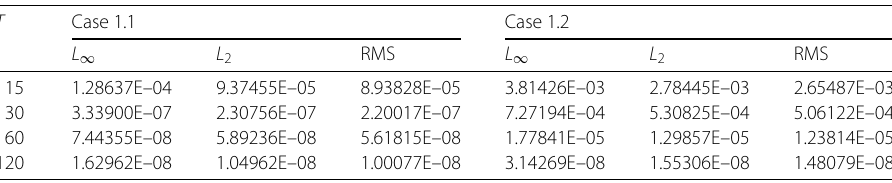
Table 3 Error norms of Example 1 using regular points